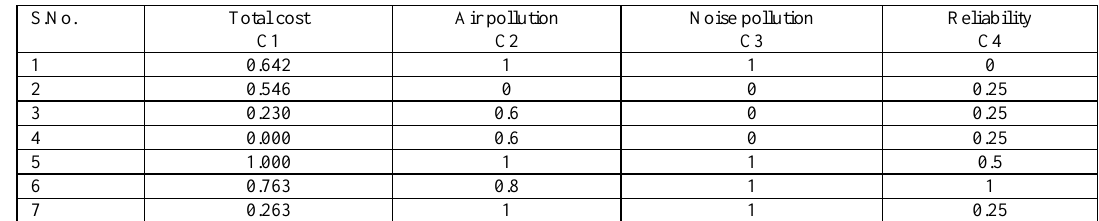
Table 9. Normalized decision